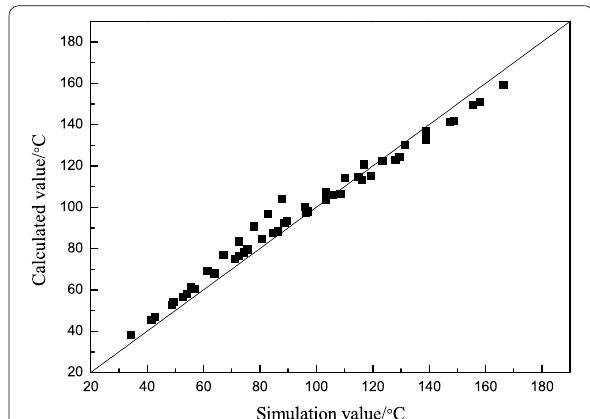
Figure 12 Heat transfer coefficient comparison of the calculation and simulation